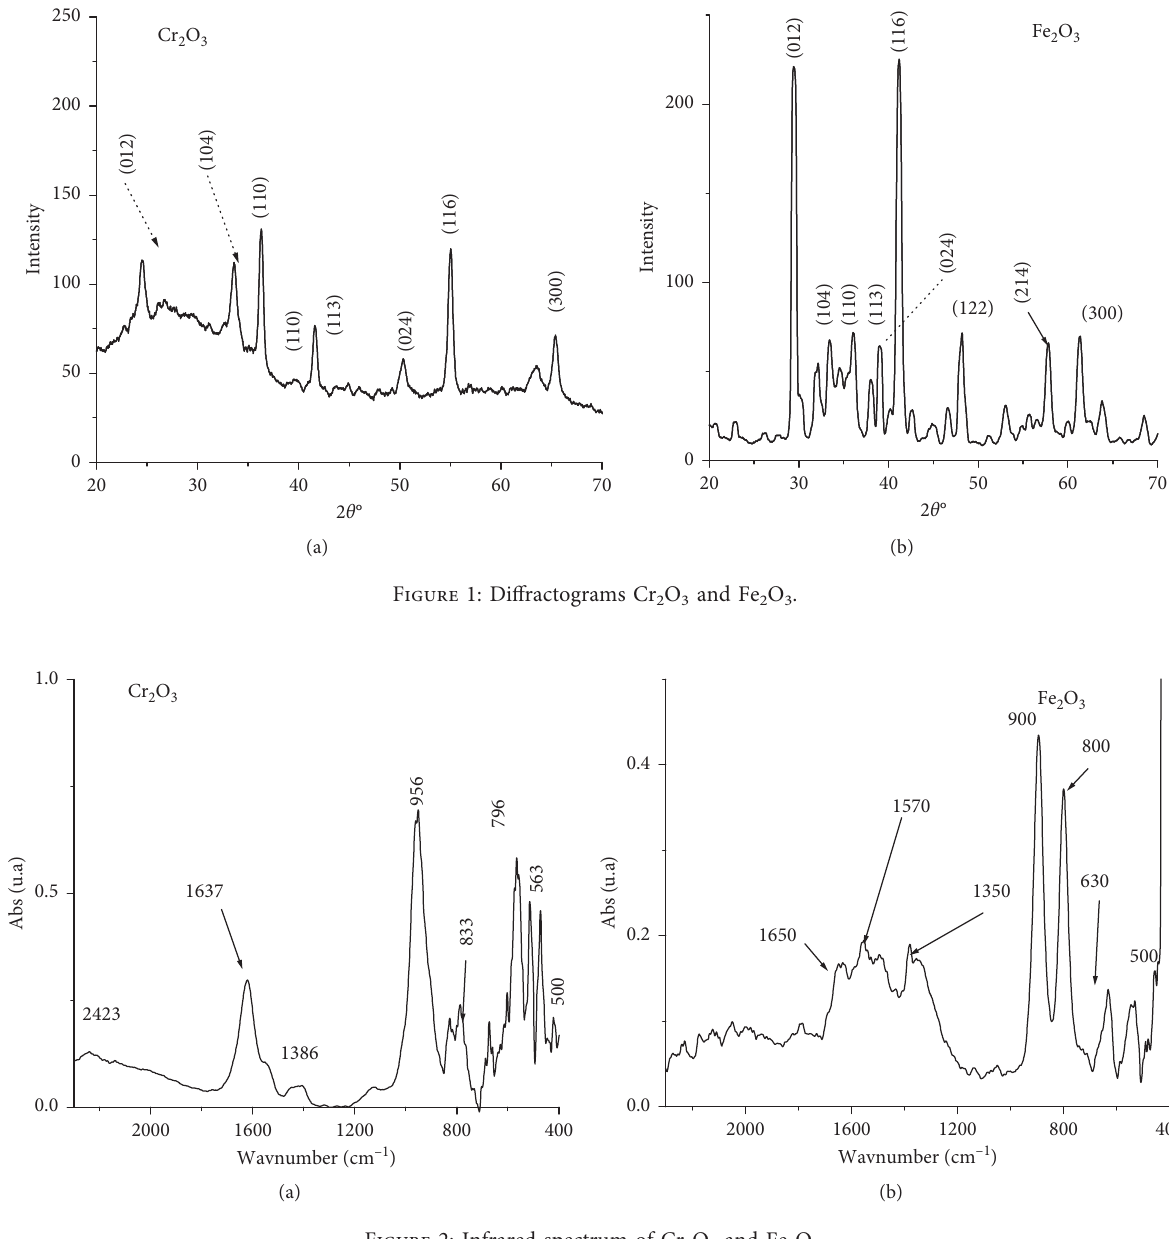
2 O 3 and Fe 2 O 3